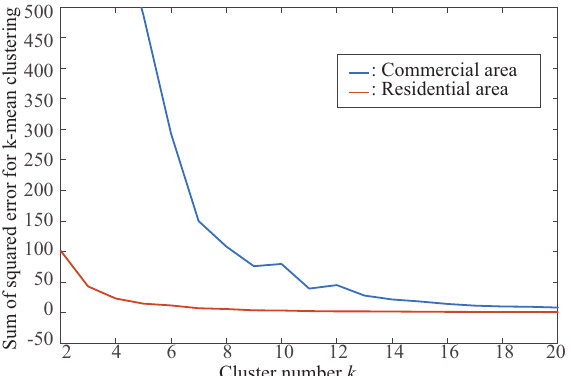
Figure 14. A comparison of SSE at commercial area and residential